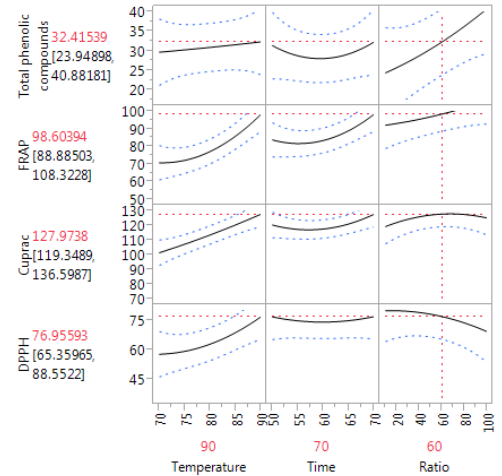
Figure 1. Prediction profiler plots for the effects of the test parameters on the extraction of phenolic compounds from olive